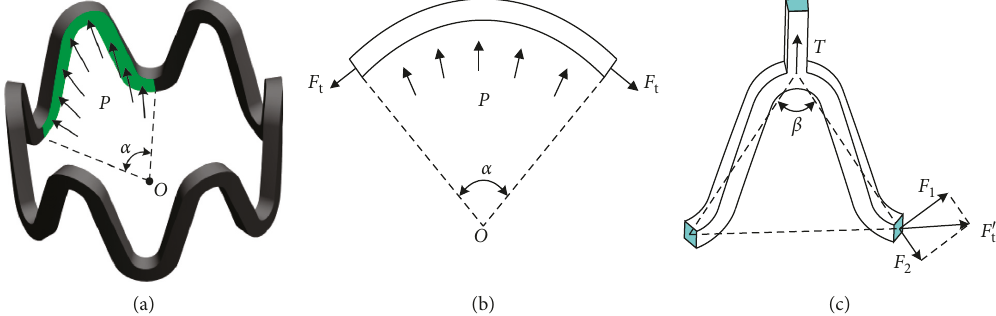
Figure 5: Diagram of the supporting ring under the balloon pressure: (a) 3D supporting ring; (b) the axial view of the supporting element; (c) the front view of the supporting element.